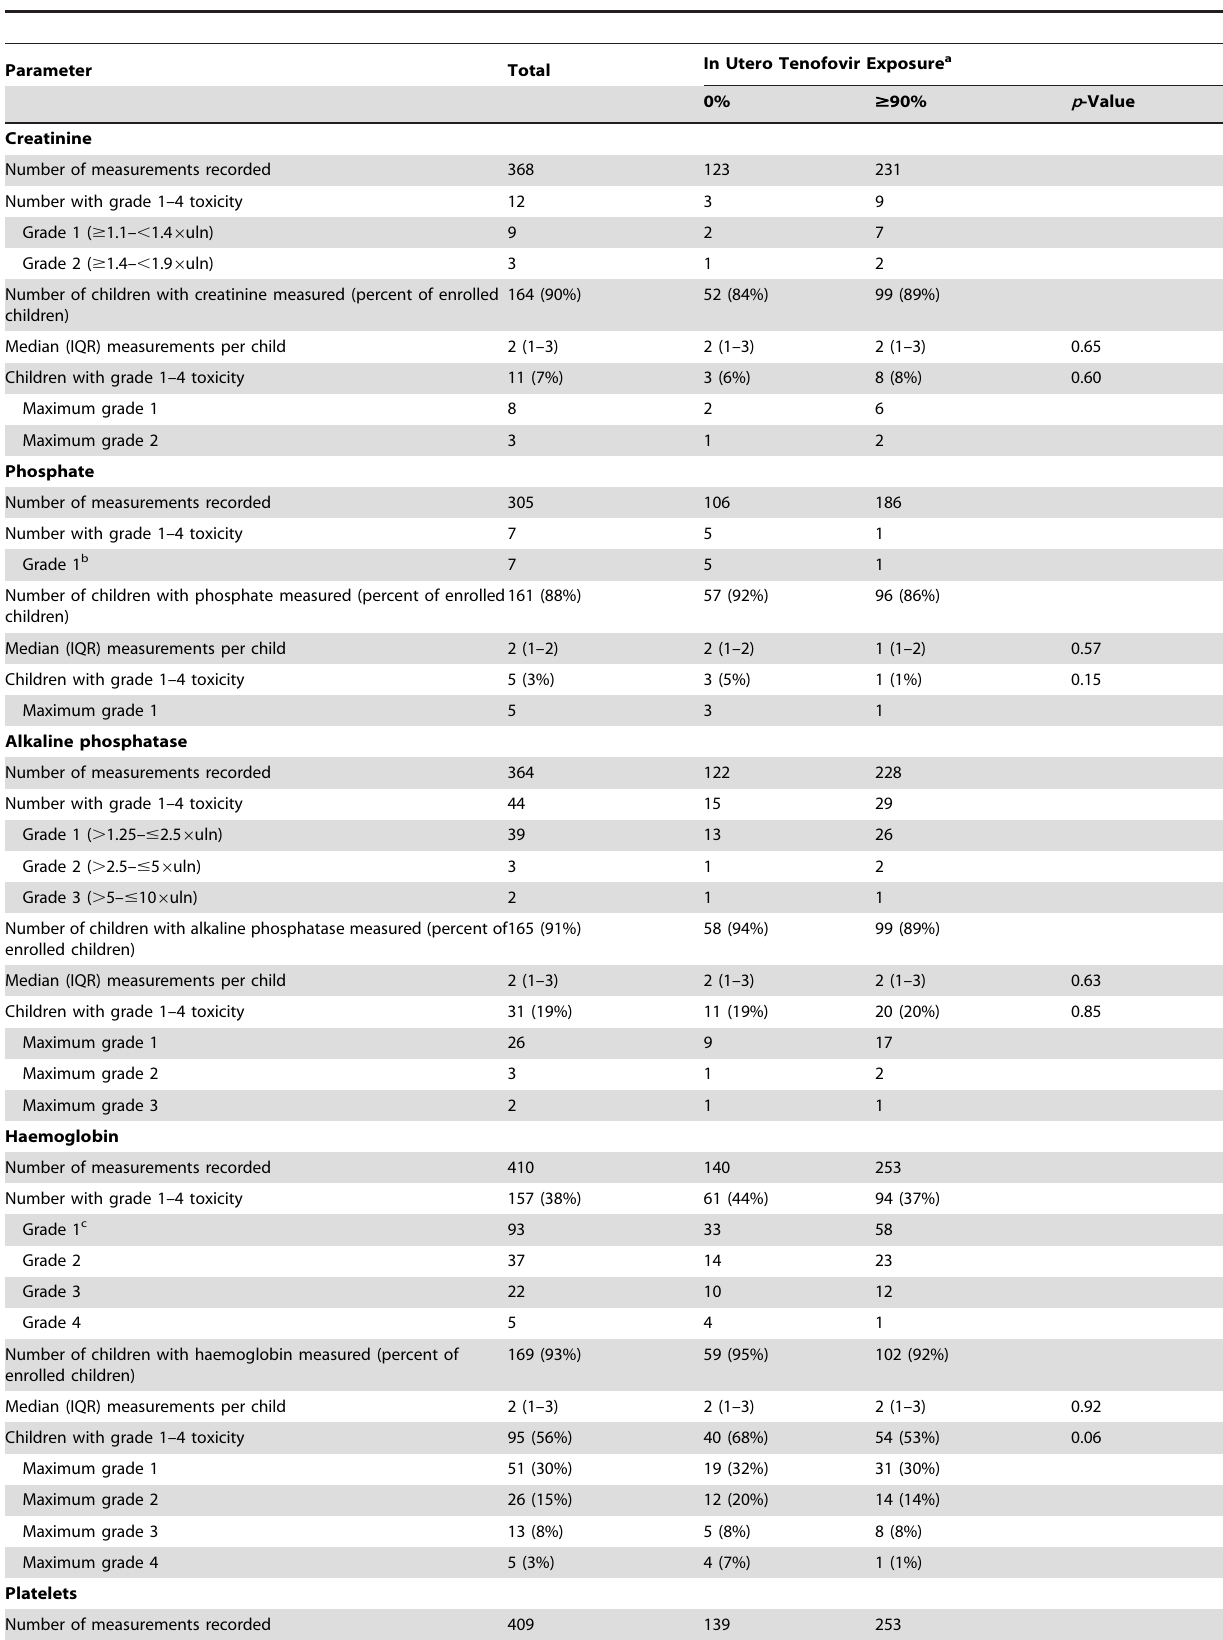
Table 2. Creatinine, phosphate, and haemoglobin toxicity.